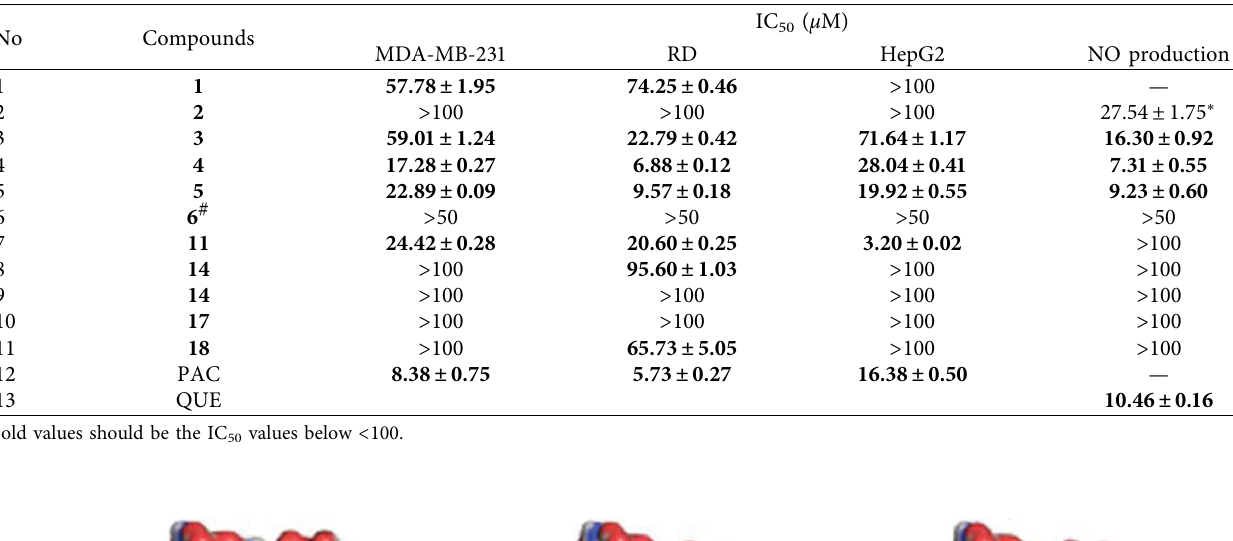
Table 3: Te antiproliferative and anti-infammatory activities of compounds ( 1 – 11 ) from M. tricolor.